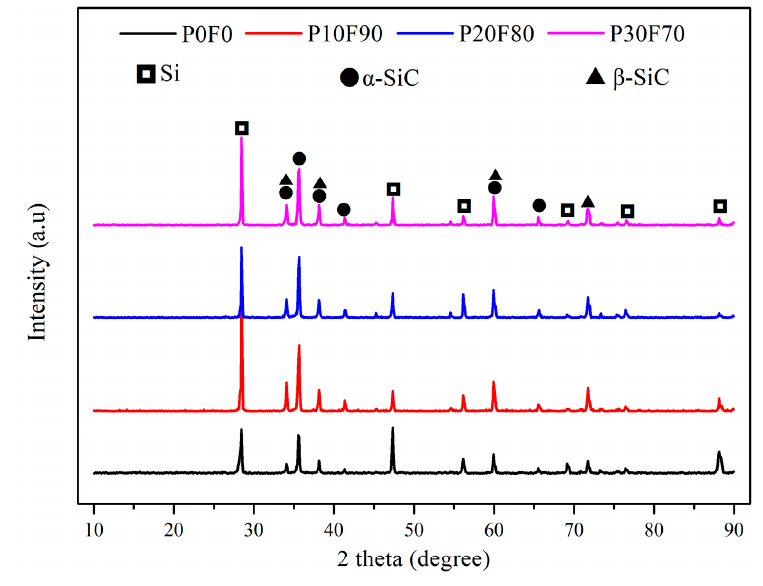
Figure 8. The XRD patterns of P0F0, P10F90, P20F80 and P30F70. The metallographic microstructure of P0F0 and P20F80 are shown in Figure 9. In Figure 9, the bright and the dark represent Si and SiC, respectively. When the concentration of PF in the composite precursor solution was 20 wt.%, the density of the porous preform reached maximum, as shown in Figure 4. Compared with P0F0 and P20F80, the increase in SiC content and residual carbon due to multiphase carbon was not observed in RB-SiC. Without multiphase carbon, the size of residual Si was 22 µ m, as shown in Figure 9a. Liquid Si reacted with multiphase carbon in P20F80, accompanied by volume expansion. The remaining Si filled the capillary channel, and eventually, dense RB-SiC was obtained. Therefore, the size of residual Si was related to the capillary channel. The introduction of multiphase carbon reduced the size of residual Si to 8 µ m, as shown in Figure 9b.